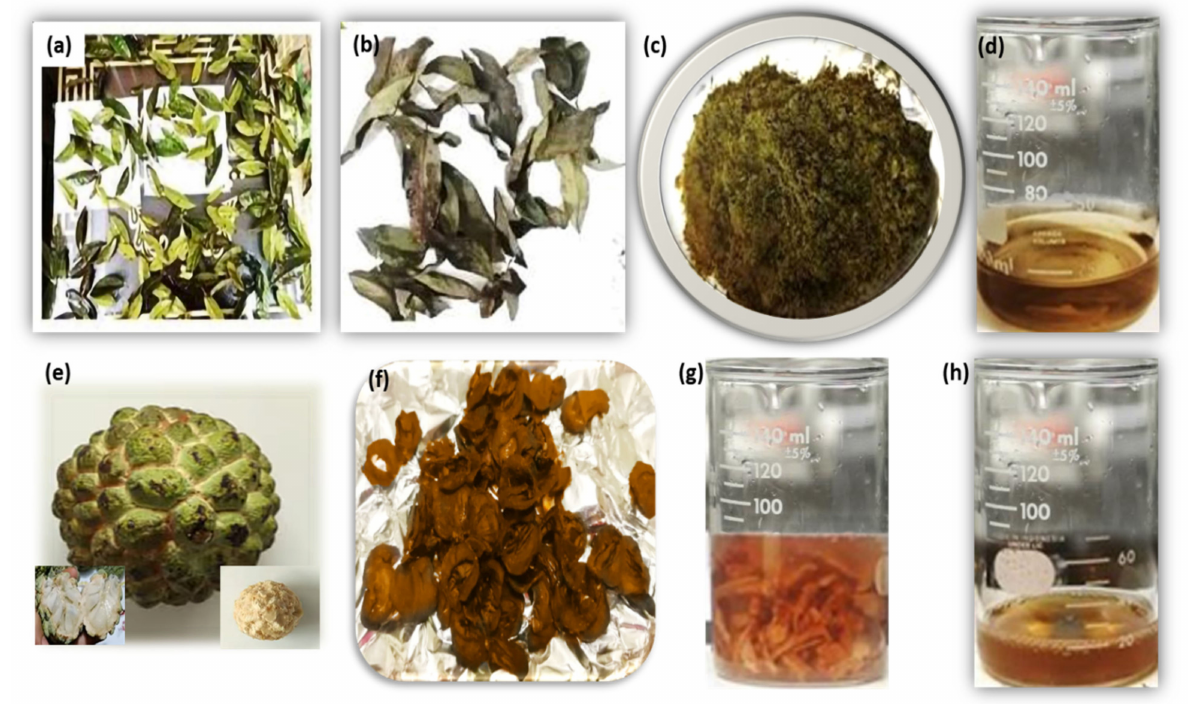
Figure 1. Steps involving the preparation of Annona squamosa from leaf extract ( a – d ), and fruit extract ( e – h ). Insets in ( e ) are the core of the fruit (left bottom) and the fruit detached from the shell (right bottom).